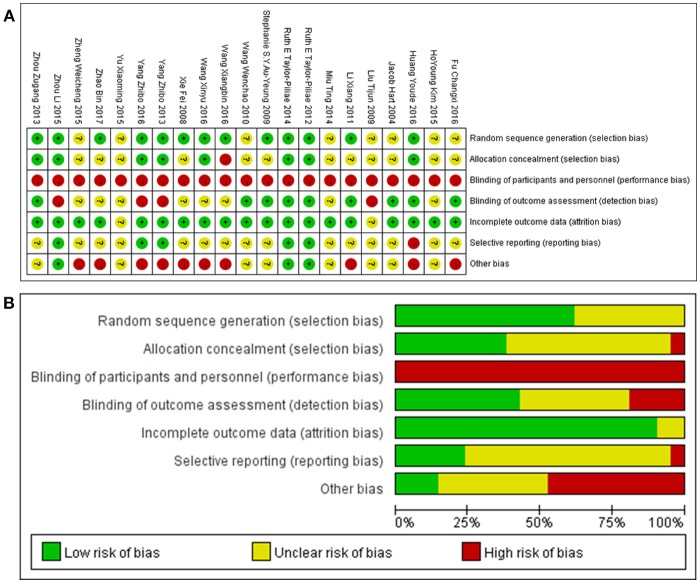
(A) Risk of bias summary: authors' judgments about each risk of bias item for each included study; (B) Risk of bias graph: authors' judgments about each risk of bias item presented as percentages across all included studies.